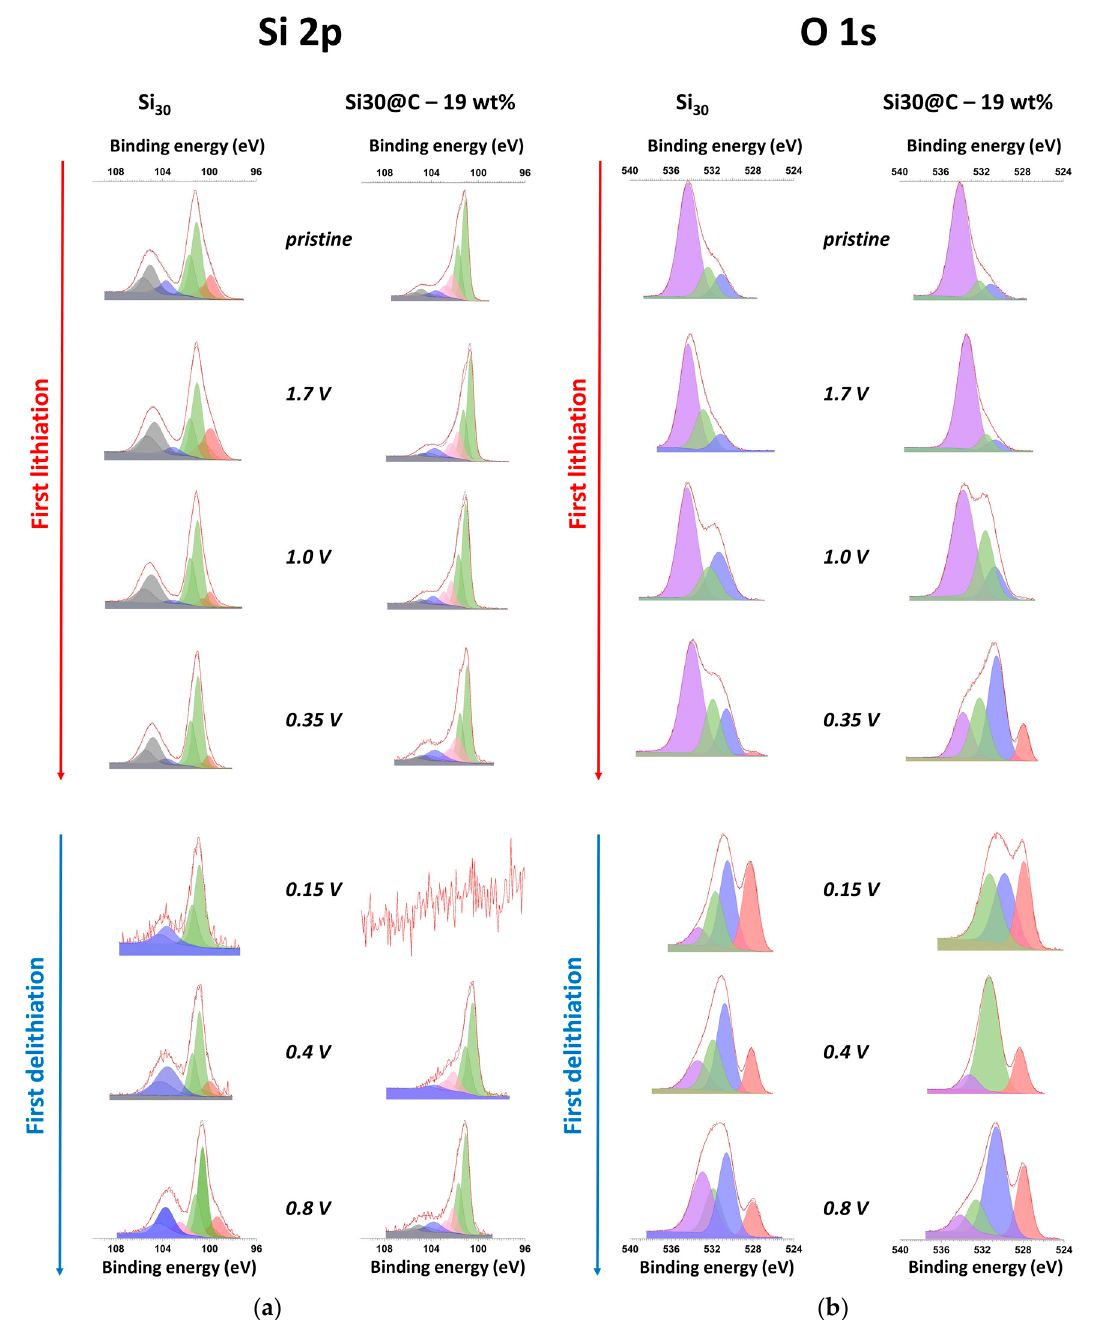
Figure 8. Example of deconvolution in different contributions of Si 2p ( a ) and O 1s ( b ) XPS signals. Each color represents the same contribution.